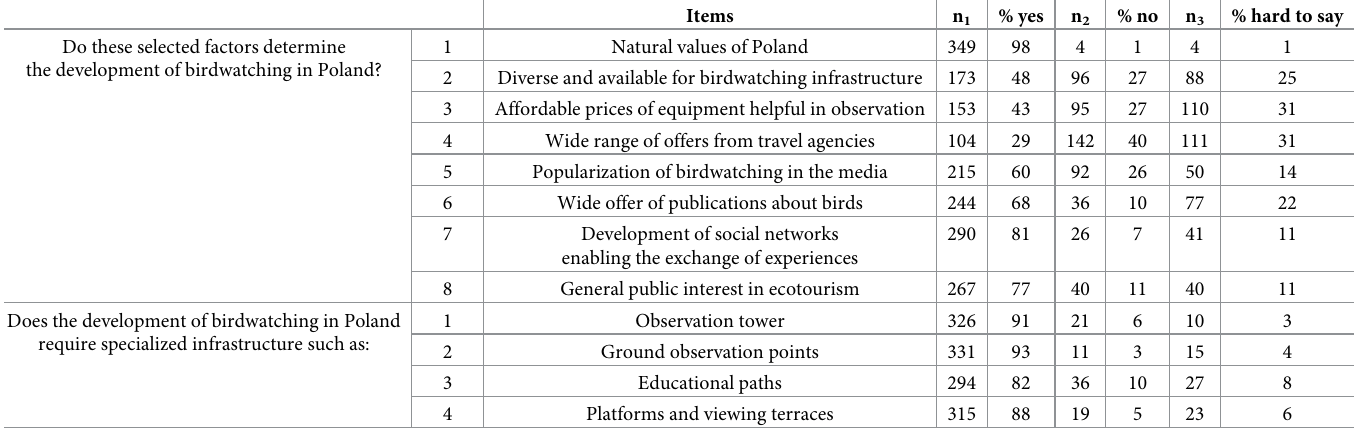
Table 3. Responses of birdwatchers regarding selected factors determining the development of birdwatching in Poland and requirement of specialized infrastruc- ture for birdwatching in